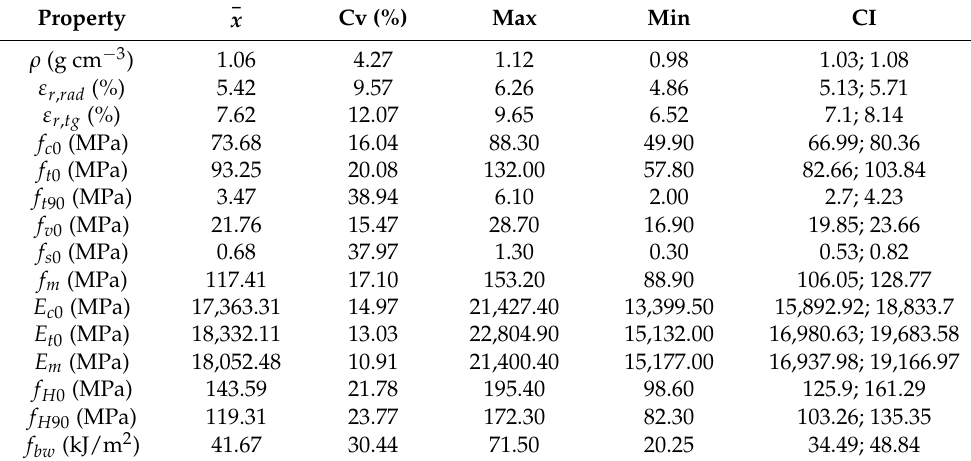
Table 3. Results of physical and mechanical properties tests for Tabebuia sp. wood from harvesting regions MT.